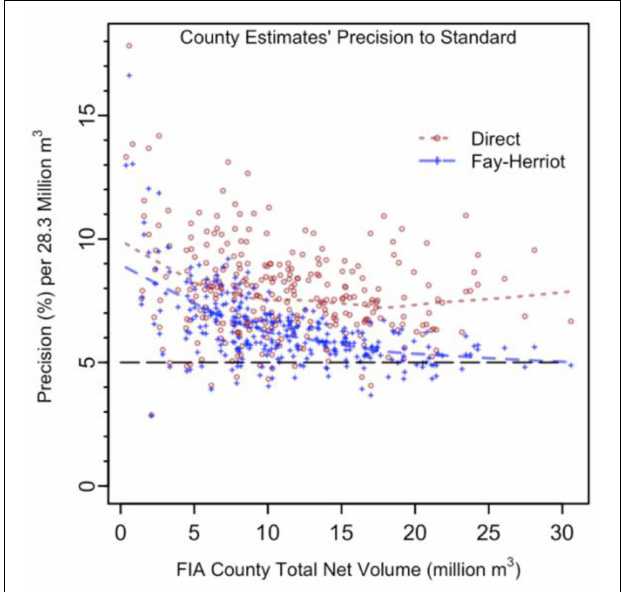
FIGURE 6 | Relative standard errors of FIA direct and FH county forest volume estimates (million m 3 ) with 5% precision standard per 28.3 million m 3